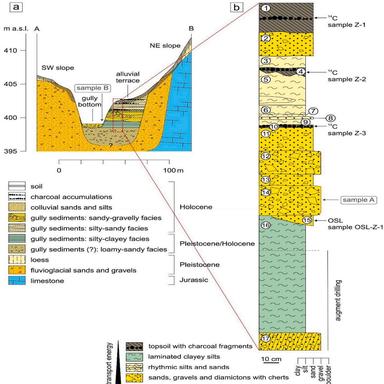
Cross-section of the studied gully in Załęze ˙ (a) and litho-stratigraphic log of the terrace (b). Numbers indicate lithological layers with visible chert-bearing layers in sandy-gravelly facies; for a detailed description of the layers, see